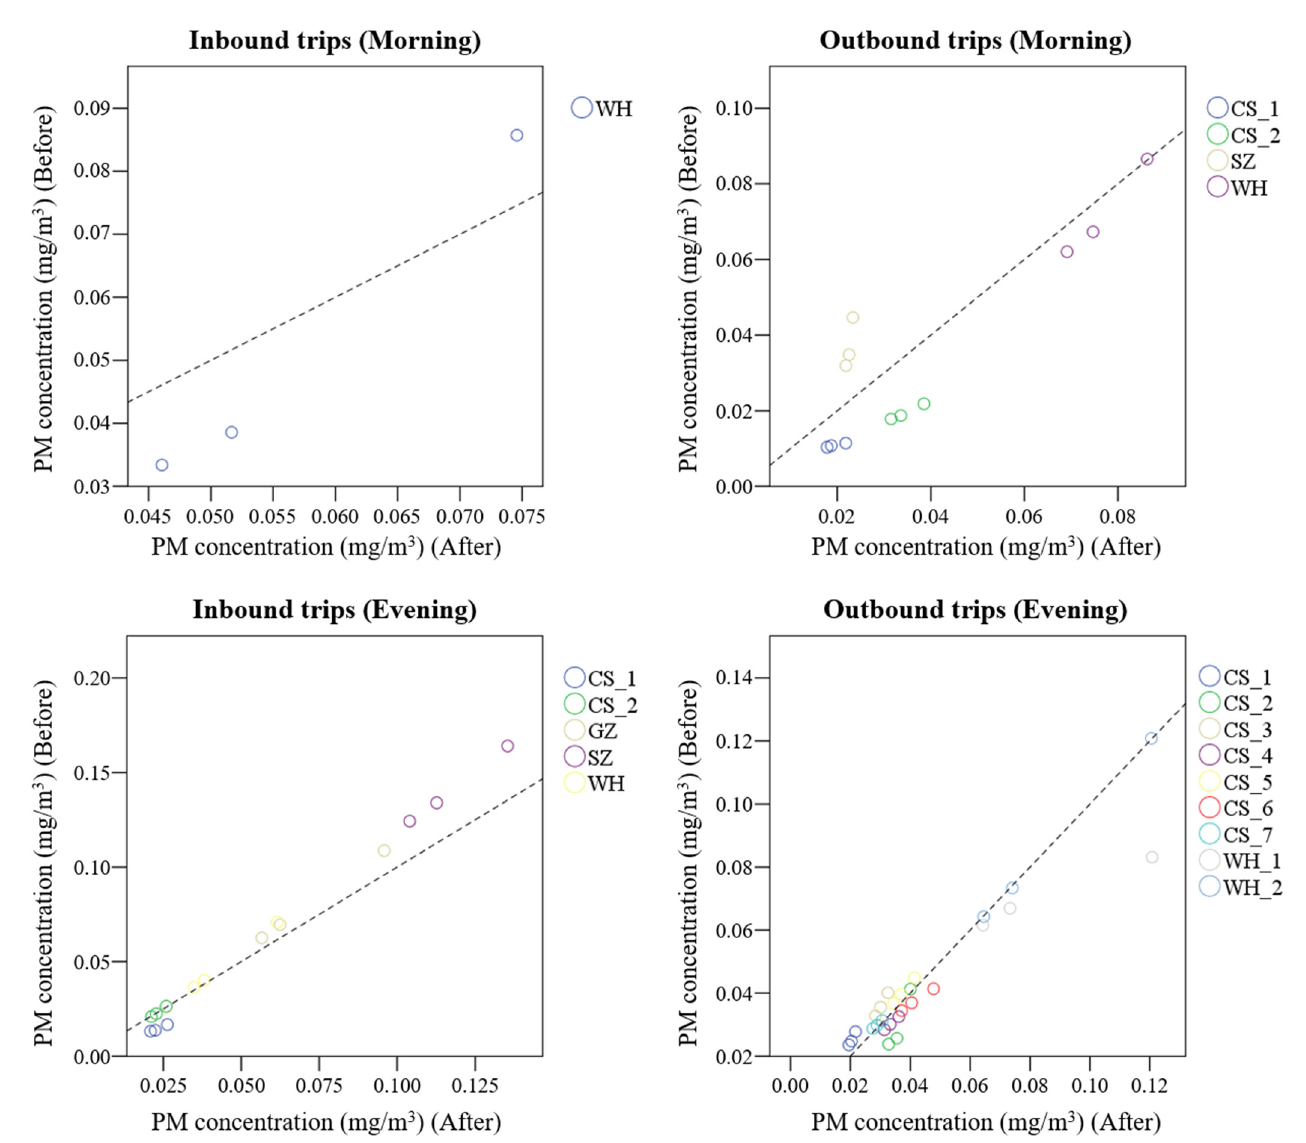
Figure 5. Comparison of particulate matter concentrations before and after changing ventilation conditions. Table 4. Description of ventilation conditions before and after the changes when commuting in a taxi.